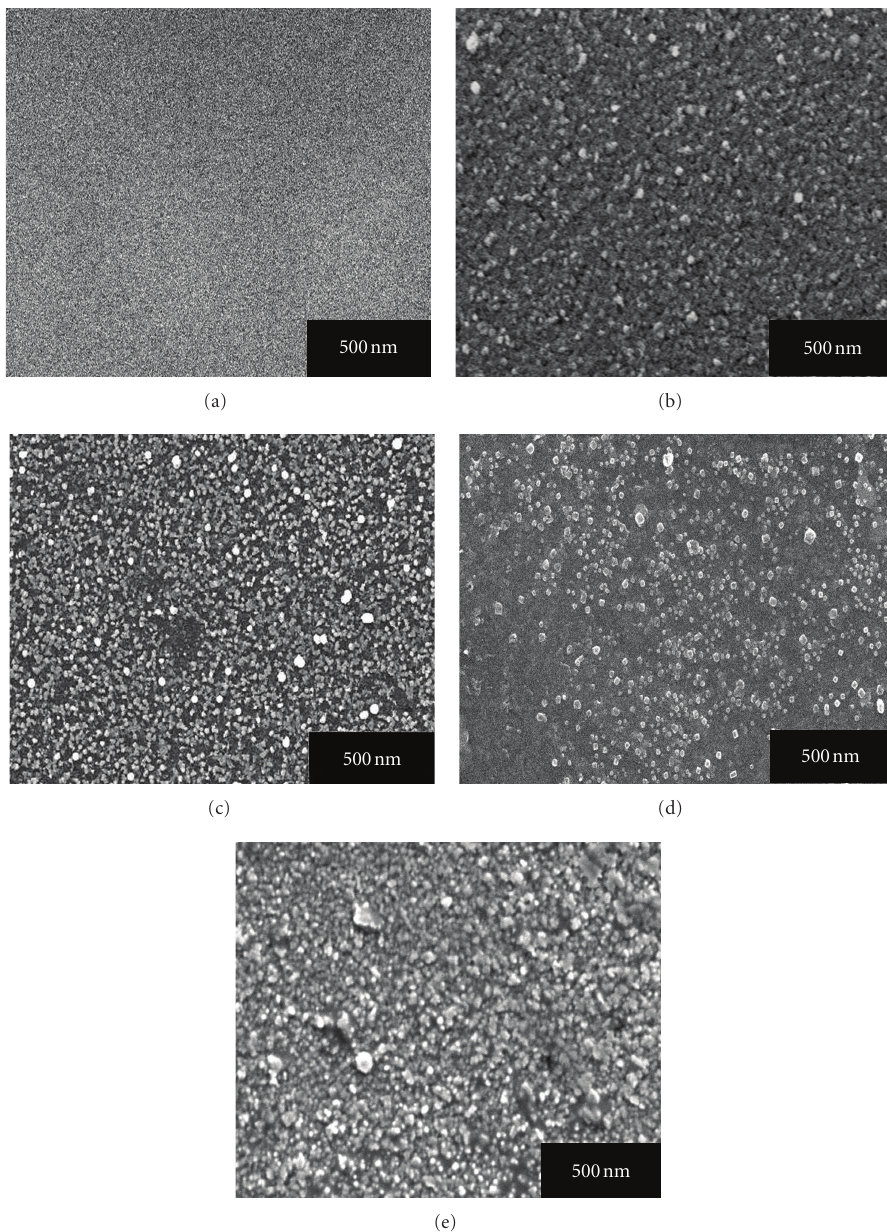
Figure 4: SEM images obtained from (a) as grown and (b) 100 ◦ C, (c) 200 ◦ C, (d) 300 ◦ C, and (e) 400 ◦ C annealed, Ag-doped nanostructured CdS thin